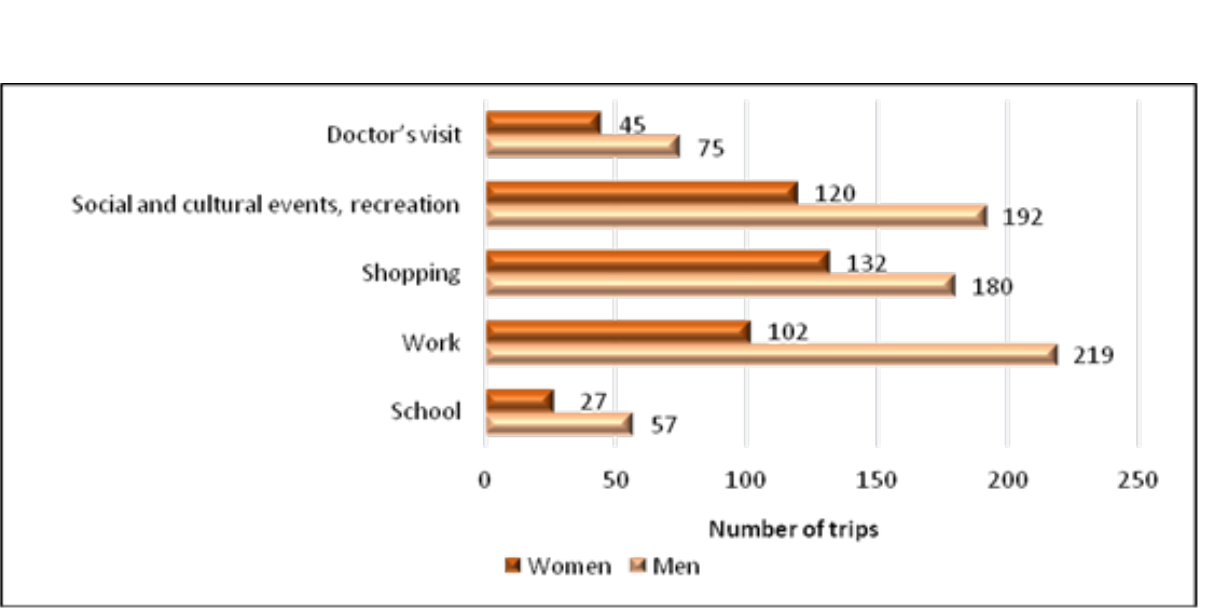
Figure 4. Purpose of transport and routing of traffic flows.